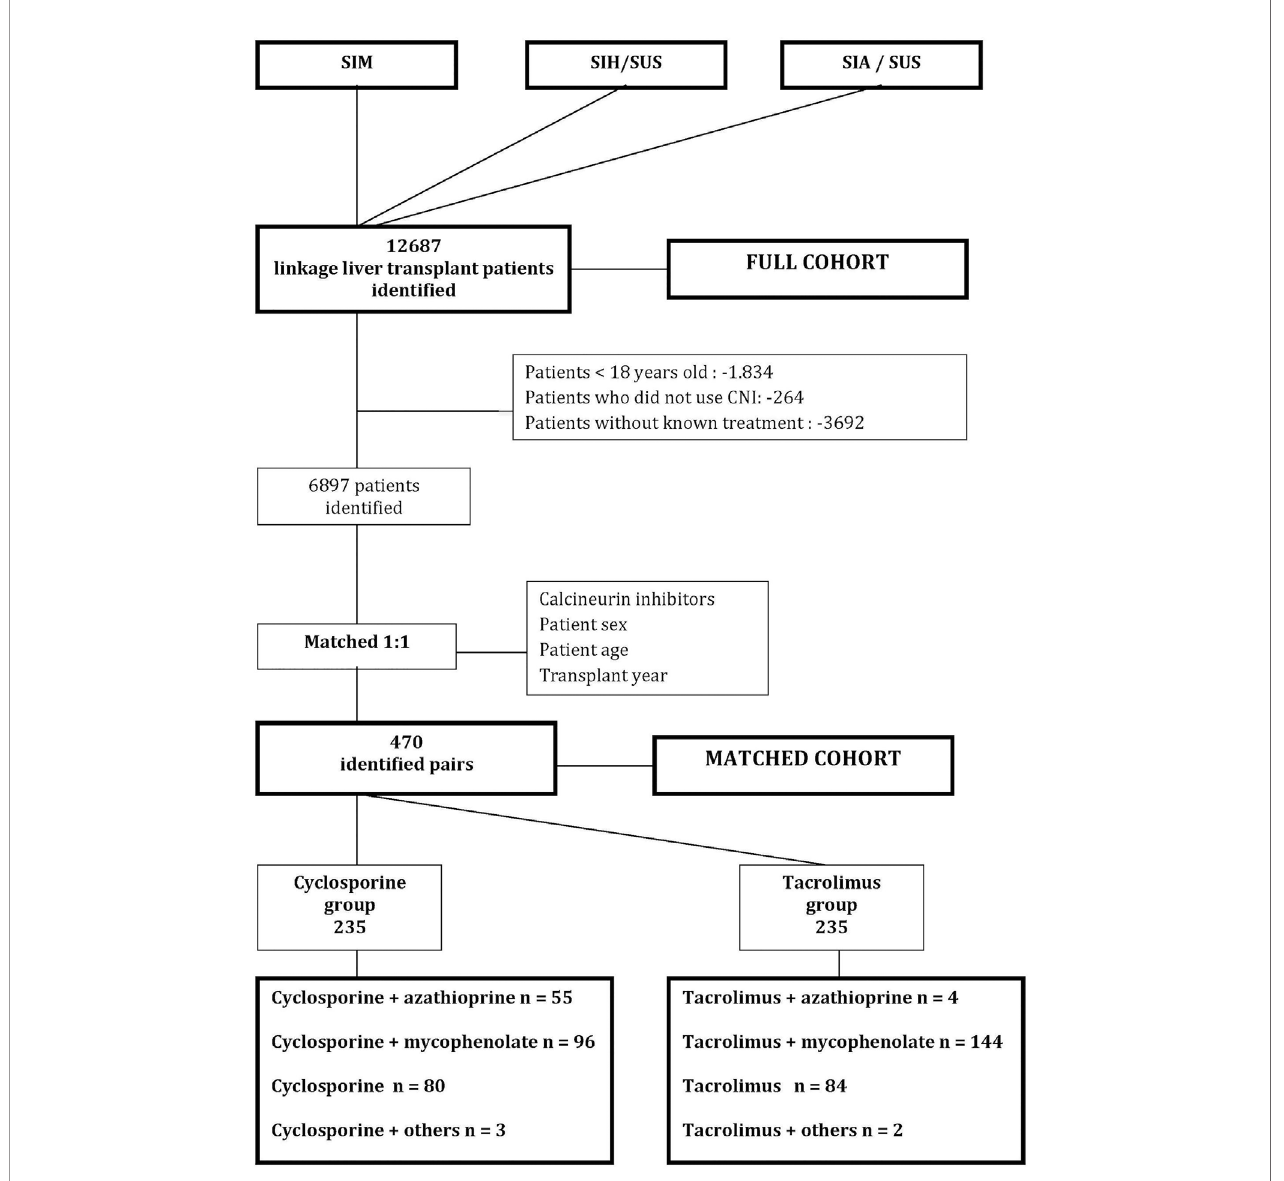
FIGURE 1 | Cohort selection fl owchart. CI, calcineurin inhibitor; SUS, Brazilian Uni fi ed Health System; SIM, Mortality Information System; SIH/SUS, Hospital Information System, SIA/SUS Outpatient Information System; Others: sirolimus or everolimus.